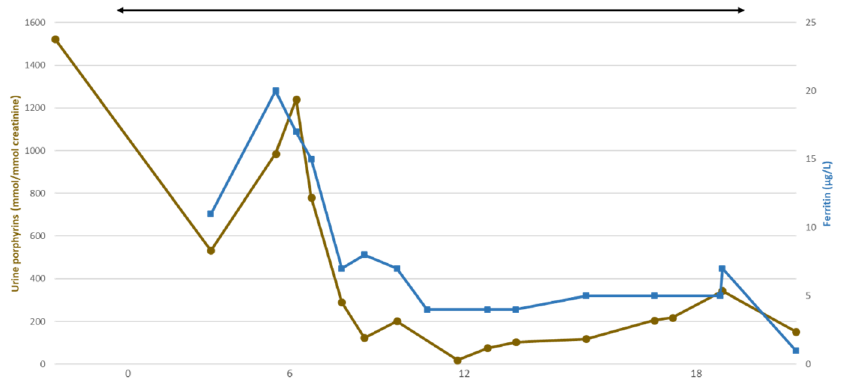
Figure 3. CEP patient’s biological parameters. Black arrow indicates iterative phlebotomies every 1 or 2 months. Total urine porphyrins (mmol/mmol creatinine, dots), ferritin (µg/L, squares). CEP: congenital erythropoietic porphyria.